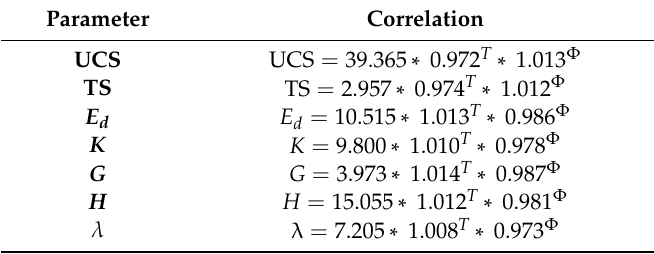
Table 8. New correlations for geomechanical parameters as a function of exposure time and porosity.